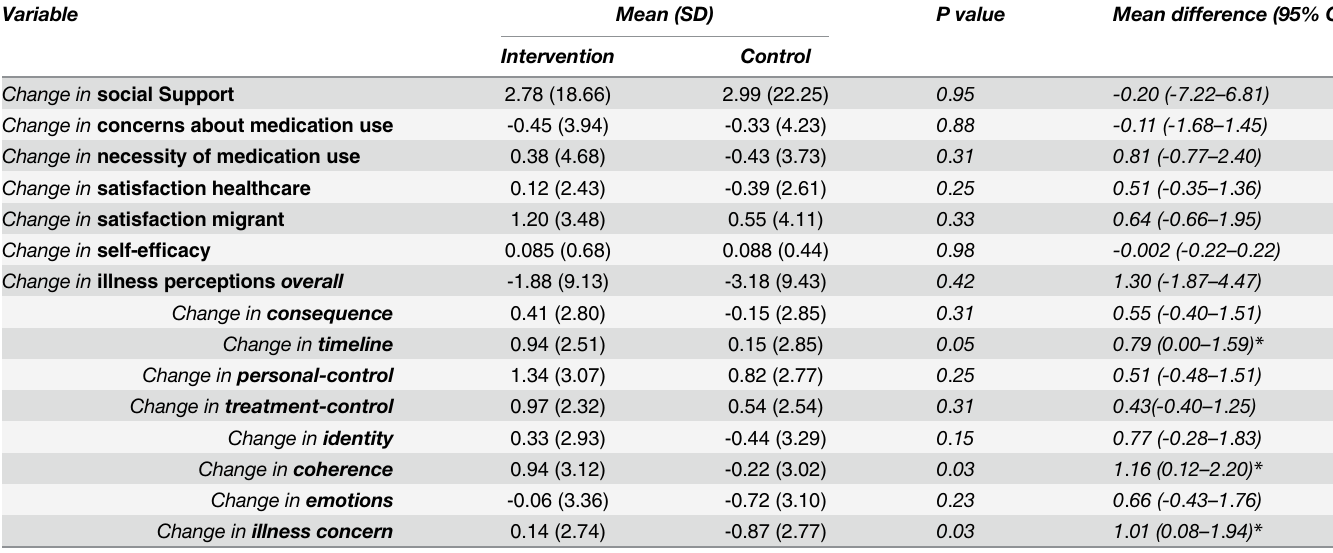
Table 4. The mean changes in patient-related determinants of adherence for patients allocated to CAHE (intervention) or usual care